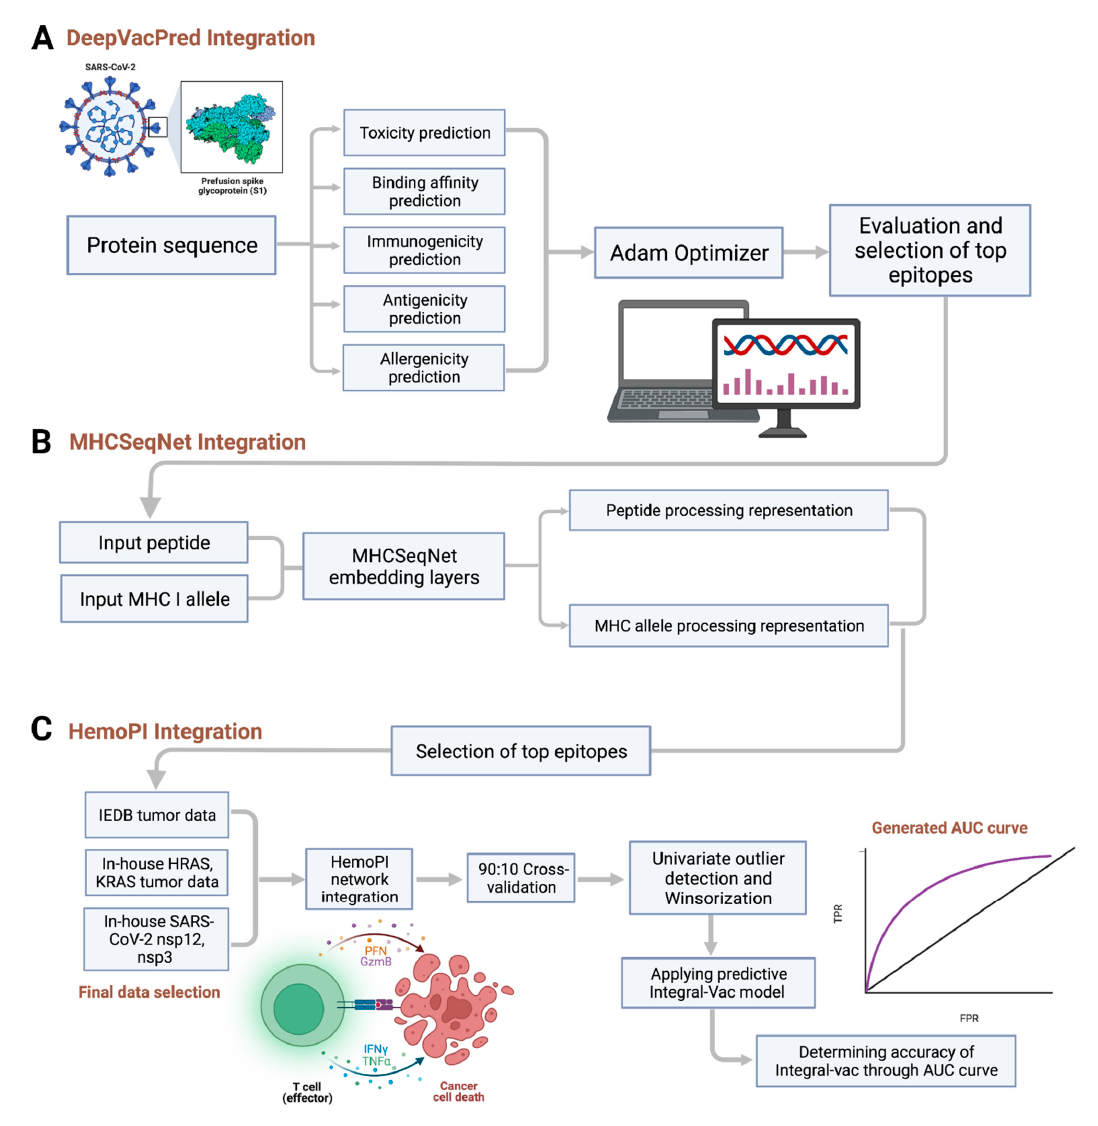
Figure 6. The overall workflow of the IntegralVac. The IntegralVac method integrates the DeepVacPred, MHCSeqNet, and HemoPI models in that order. Our method operates by initially predicting binding affinity, then immunogenicity scores, and then use of optimization to ensure that outliers are excluded from the amino acid sequence data used for making these predictions. Finally, other checkpoint filters are also predicted, and final rounds of optimization are performed. ( A ) describes the initial integration of DeepVacPred into DeepVacPred using the Adam optimizer. As per ( A ), IntegralVac utilizes DeepVacPred to expand upon binding affinity and immunogenicity predictions with additional checkpoint prediction filters, including toxicity, antigenicity, and allergenicity, followed by optimization. Part ( B ) involved using MHCSeqNet’s embedding layers to further optimize the model for MHC Class I peptides. This method helped us remove duplicated and ambiguous entries from IntegralVac’s dataset, and the Adam optimizer in the previous step also removed low-confidence entries. This exclusion of outlier data contributed to slightly improving prediction accuracy. Following MHCSeqNet integration and further narrowing down the list of top epitopes, ( C ) indicates HemoPI integration along with finalized optimization of IntegralVac. Additionally, these epitopes were combined with in-house cancer and COVID dataset, then cross-validated and Winsorized. Together, the integrated models make up IntegralVac, of which the AUC and accuracy were